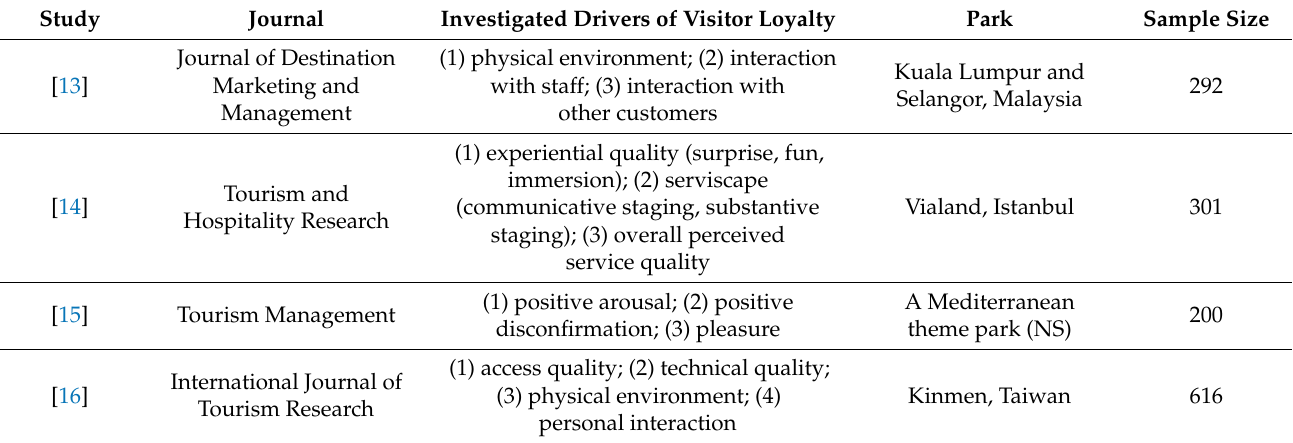
Table 1. Previous research exploring the drivers of leisure parks’ visitors’